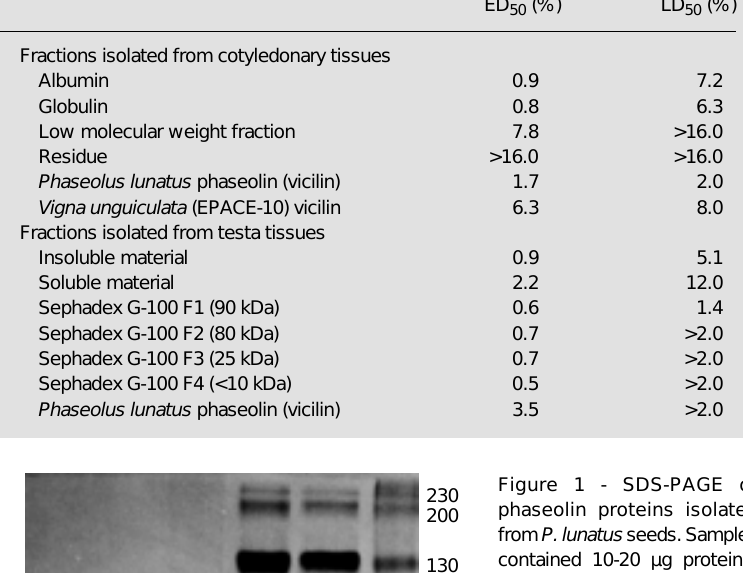
Figure 1 - SDS-PAGE of phaseolin proteins isolated from P. lunatus seeds.